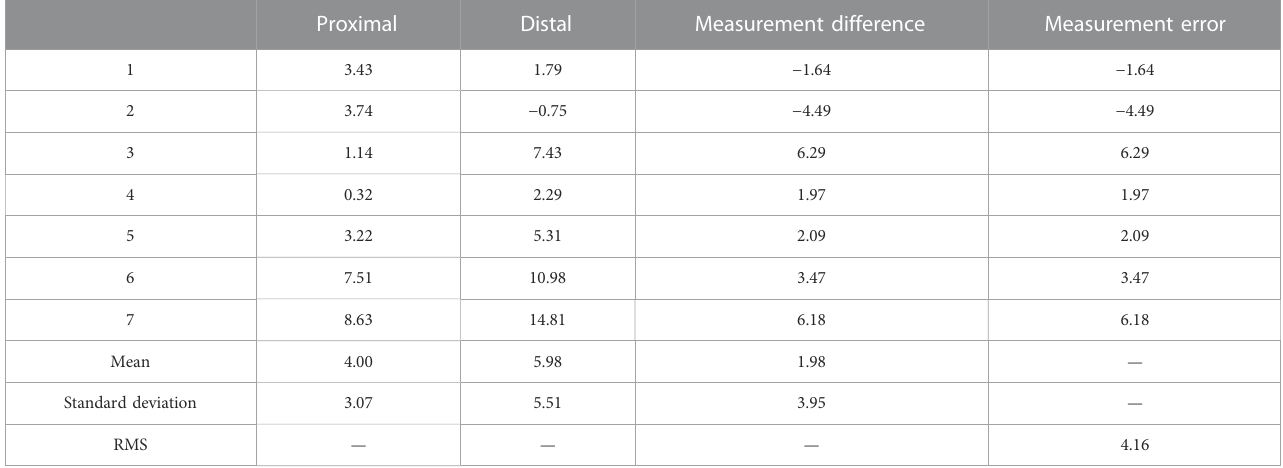
TABLE 5 Statistics of dynamic accuracy test data of GGMS( T xy ). Proximal Distal Measurement